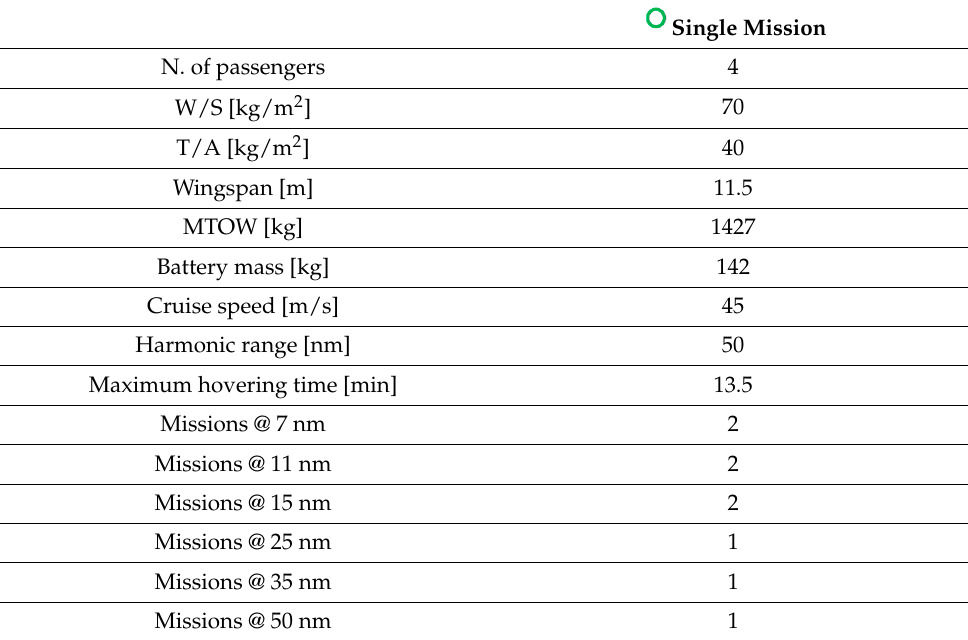
Figure 20. Details of the TiltOne configuration for single mission case: ( a ) top view; ( b ) mass breakdown. Table 14. Main performance data of the TiltOne configuration for single mission case.